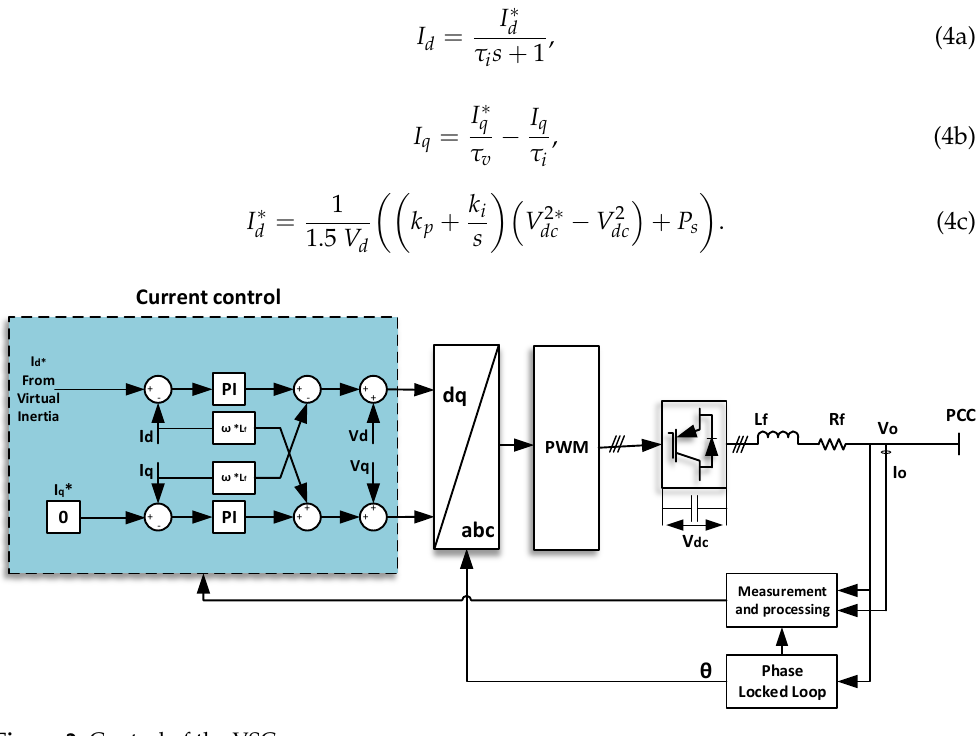
Figure 2. Control of the